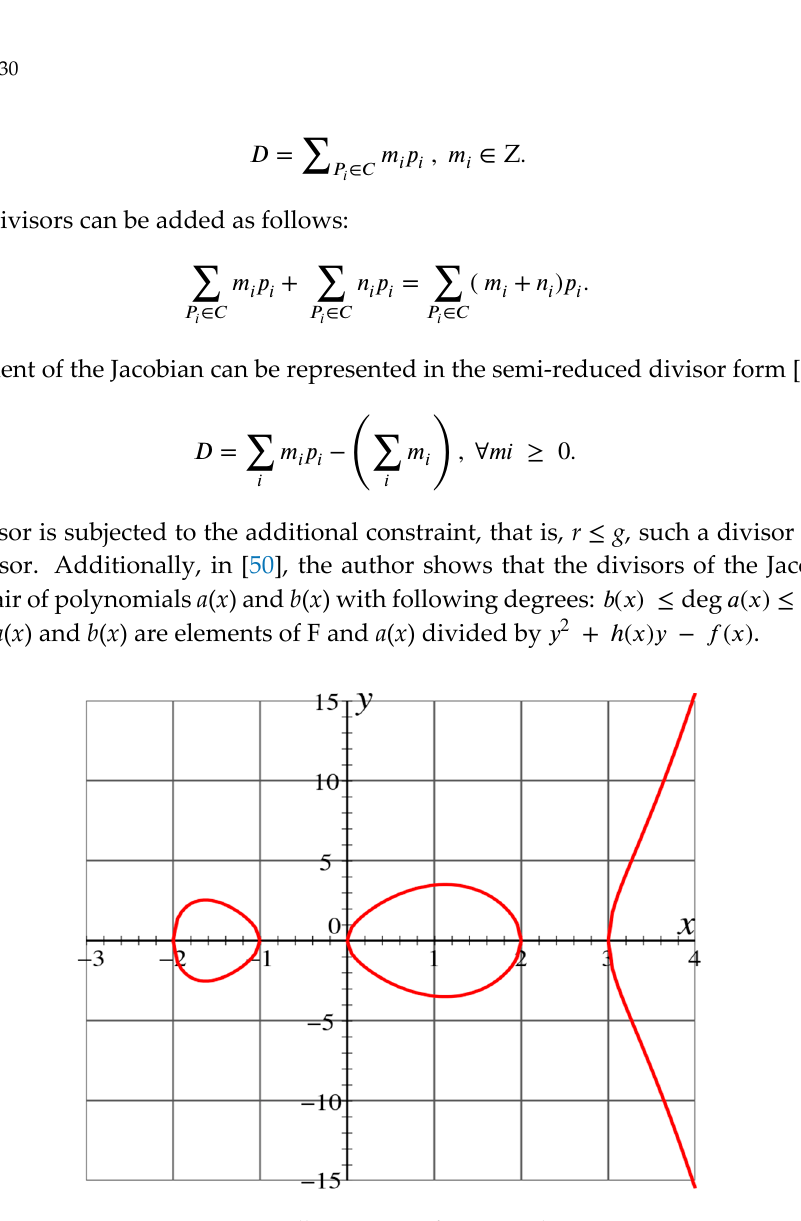
Figure 1. Hyper elliptic curve of genus 2, that is, g = 2.